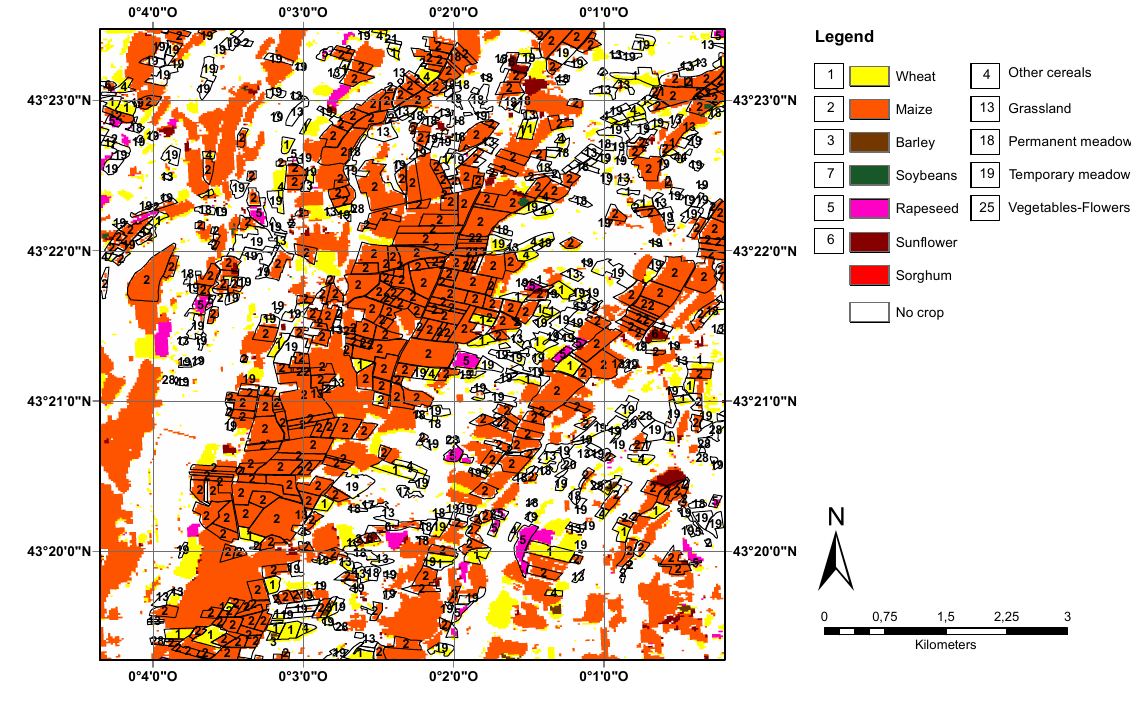
Figure 6. Comparison of the crop map type obtained using the RF classifier and field surveys with the Registre Parcellaire Graphique (RPG) database on a high altitude region far from the field data collection site. Numbers indicate the crop type in the reference data, and colors correspond to the output of the